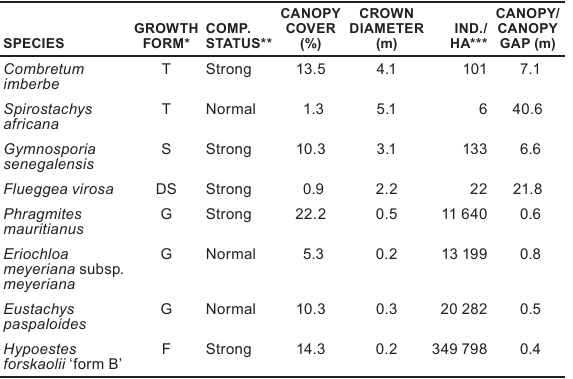
* T = Tree; DS = Dwarf shrub; G = Grass; F = Forb ** Competitor status *** Individuals per